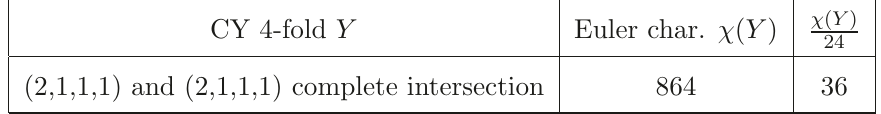
Table 4 . Euler characteristic of complete intersections of (2,1,1,1) and (2,1,1,1) hypersurfaces in P 3 × P 1 × P 1 × P 1